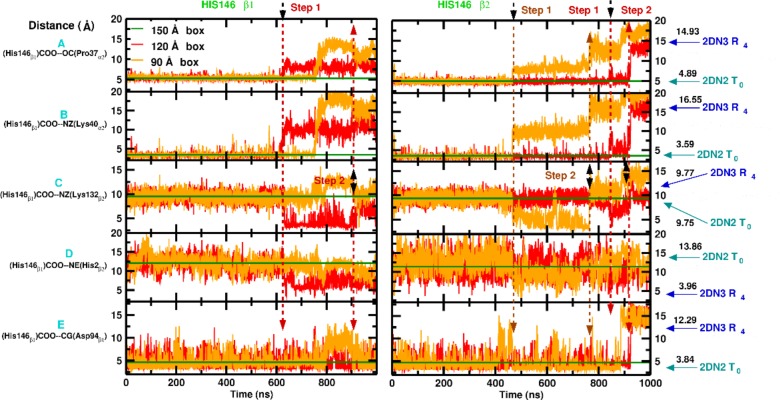
Local structural changes around His146.Left: Interactions involving His146β. Right: Interactions involving His146β. From top to bottom: [a] water-mediated contact between (His146β)COO−–OC(Pro37α), [b] the salt bridge between (His146β)COO−–NZ(Lys40α), [c] the contact between (His146β)COO−–NZ(Lys132β), [d] the contact between (His146β)COO− and NE(His2β) and [e] the salt bridge between (His146β)NE2 and COO−(Asp94β). Cyan and blue arrows indicate the corresponding values found in crystal structure of the deoxy (2DN2) and oxy (2DN3) state, respectively. The dashed lines indicate breaking points along the 1μs MD simulation and the black arrows indicates the first to break. The straight green line represents the averaged distance over 1 μs of MD simulation for the 150 Å box as reference.